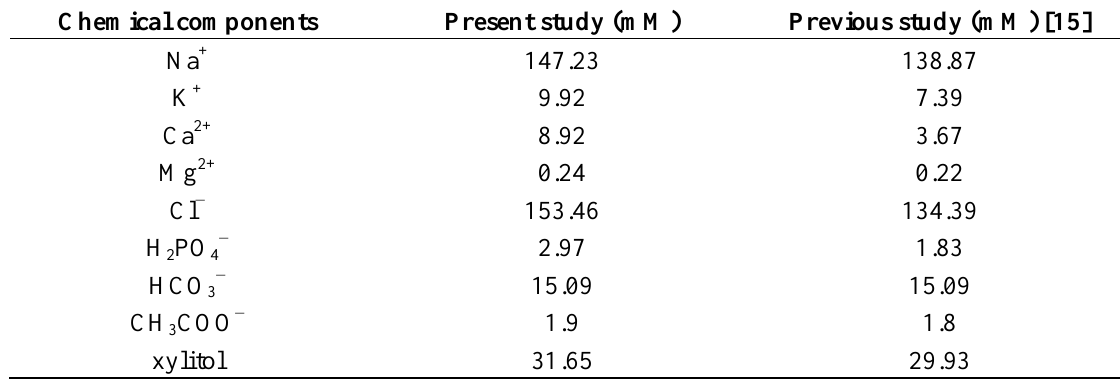
Table 2. Chemical composition of the infusion fluid-based supersaturated CaP